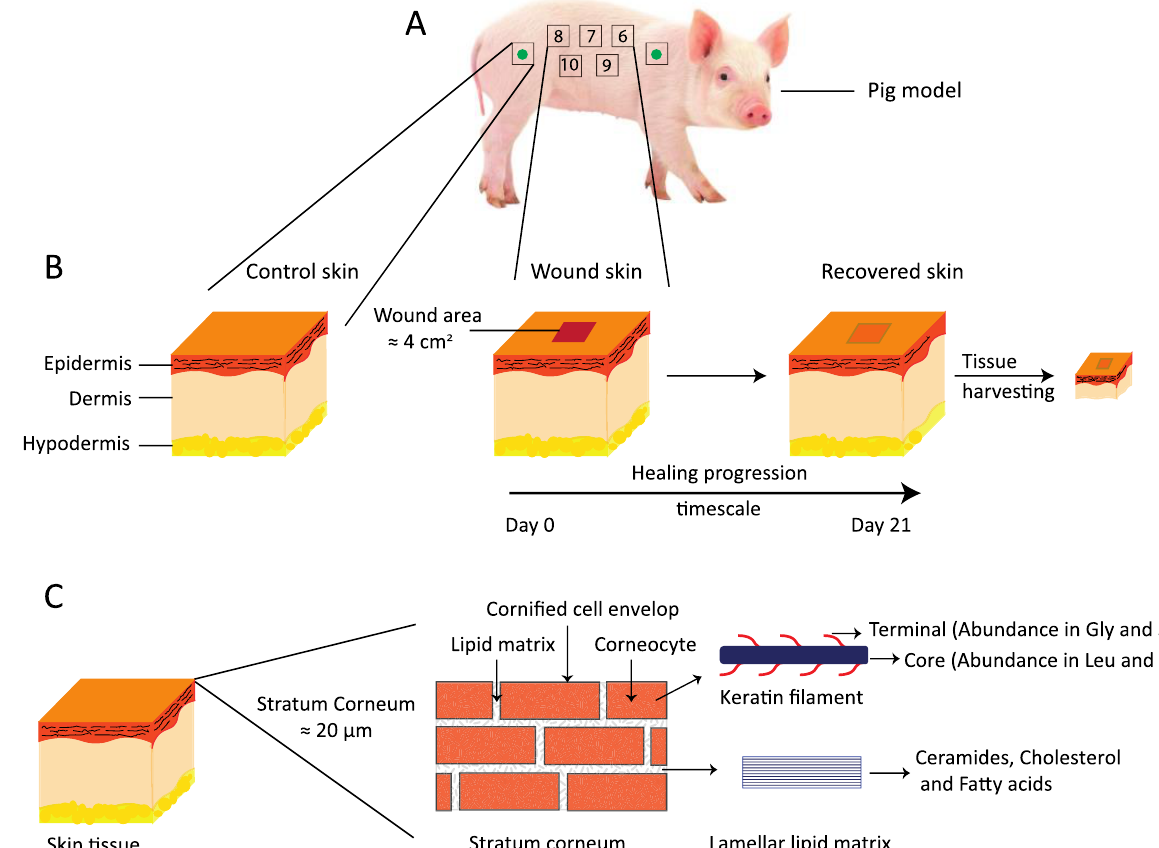
Figure 1. ( A ) A schematic of the wound healing study design. The study was performed on two non-naïve Göttingen minipigs. A total of 10 wounds were generated on each pig, five on the left side of the pigs back and five on the right side, as shown here with numbers from 6 to 10. The green filled circle inside the square indicates regions from where the control skin tissues were harvested at the end of the in vivo study. ( B ) A simplified drawing showing three major layers of the skin: the epidermis, the dermis, and the hypodermis. The wound incision area, which is approximately 2 × 2 cm 2 , is shown, along with the time scale for healing progression over 21 days. After the in vivo study, the recovered skin was harvested for further evaluation ex vivo. ( C ) A cartoon presenting the thin top layer of the epidermis, the stratum corneum, which can be illustrated with bricks and mortar. The bricks in the cartoon represent anucleated corneocytes, mainly composed of keratin filaments. The corneocytes are embedded in a lipid lamellar matrix constituting the mortar. These lipid lamellae mainly comprise ceramides, cholesterol, and free fatty acids.